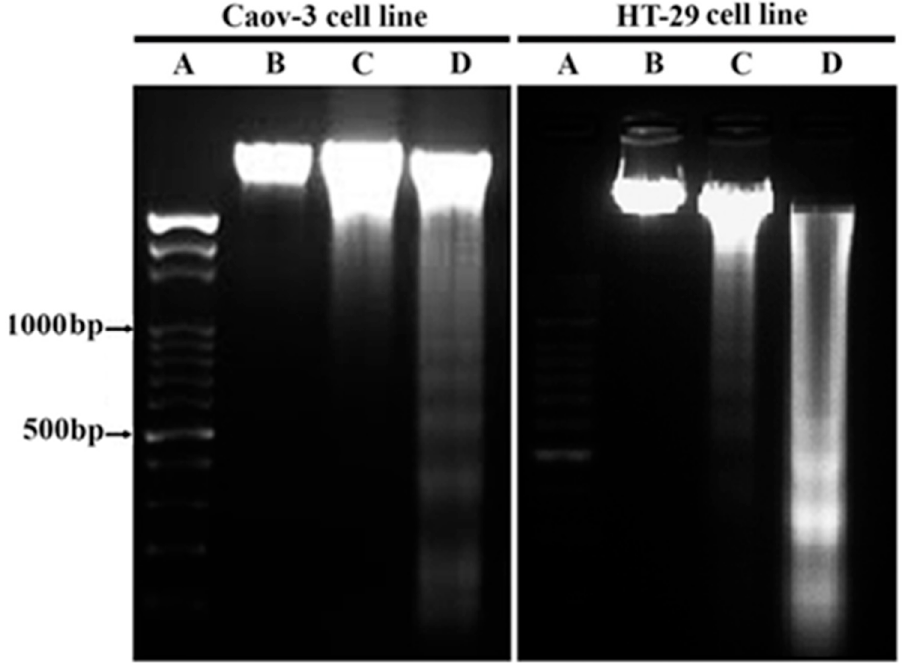
Figure 3. DNA fragmentation assay. Lane A: 1000 bp molecular weight marker, Lane B: untreated cells, Lane C: treated cells for 48 h, Lane D: treated cells for 72 h.